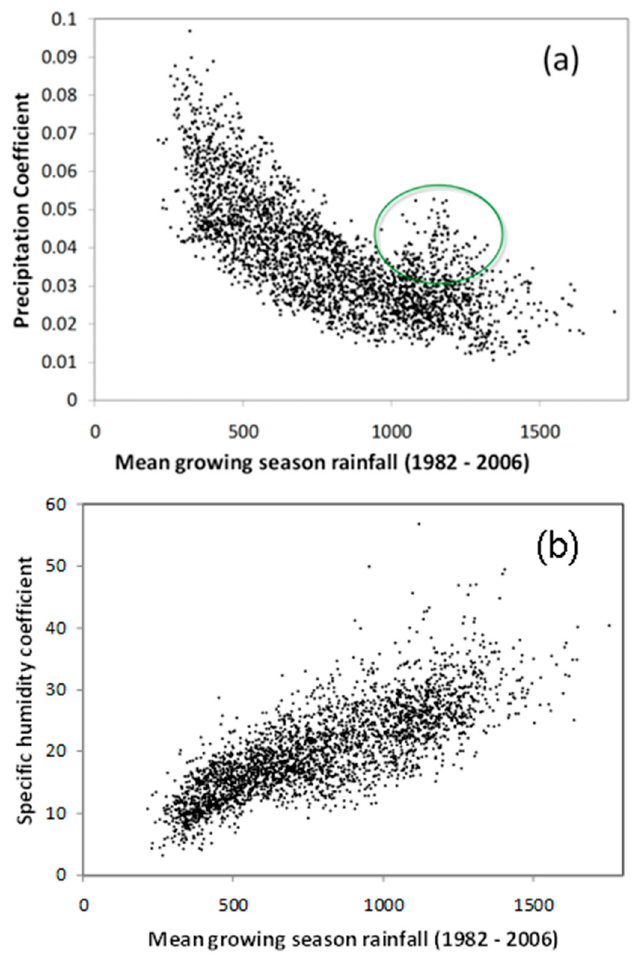
Figure 10. A randomly drawn sample (10%) representing the relationship of rainfall climatology to ( a ) precipitation coefficient Σ NDVI · mm − 1 and ( b ) specific humidity coefficient Σ NDVI